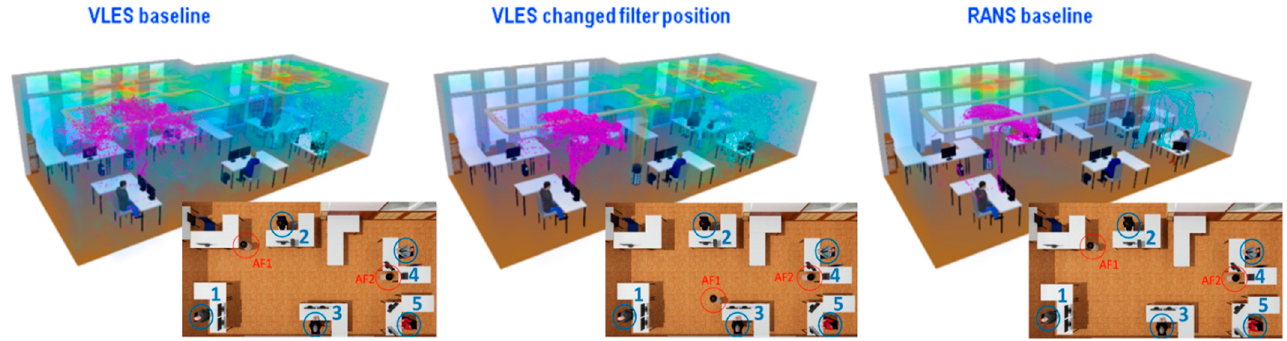
Figure 16. Distribution of the particle concentration for a coughing scenario simulated after 50 s using different simulation methods and positions of the air cleaner.